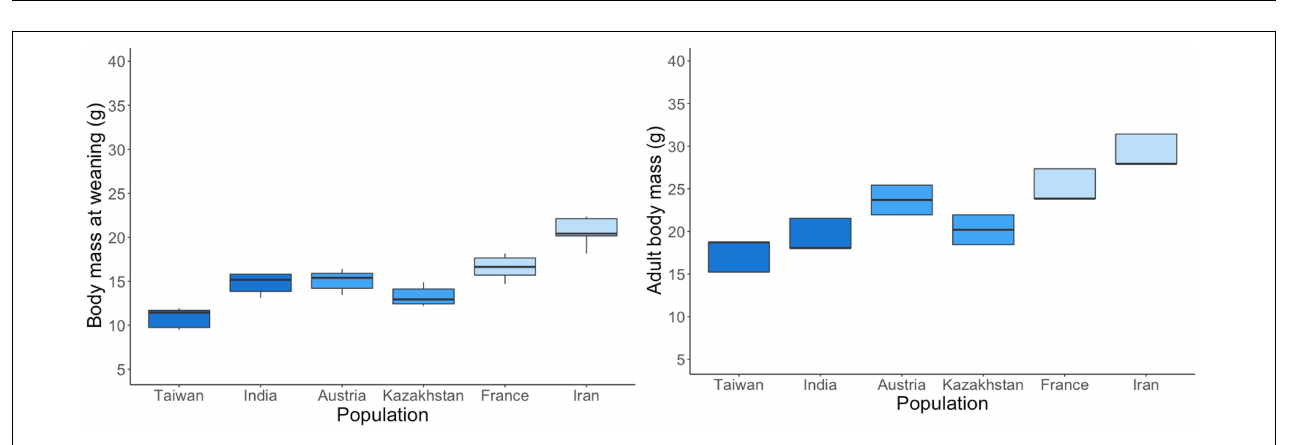
FIGURE 3 | Littersize at weaning of the Mus musculus populations. The two populations per subspecies are shown in the same shade of blue.